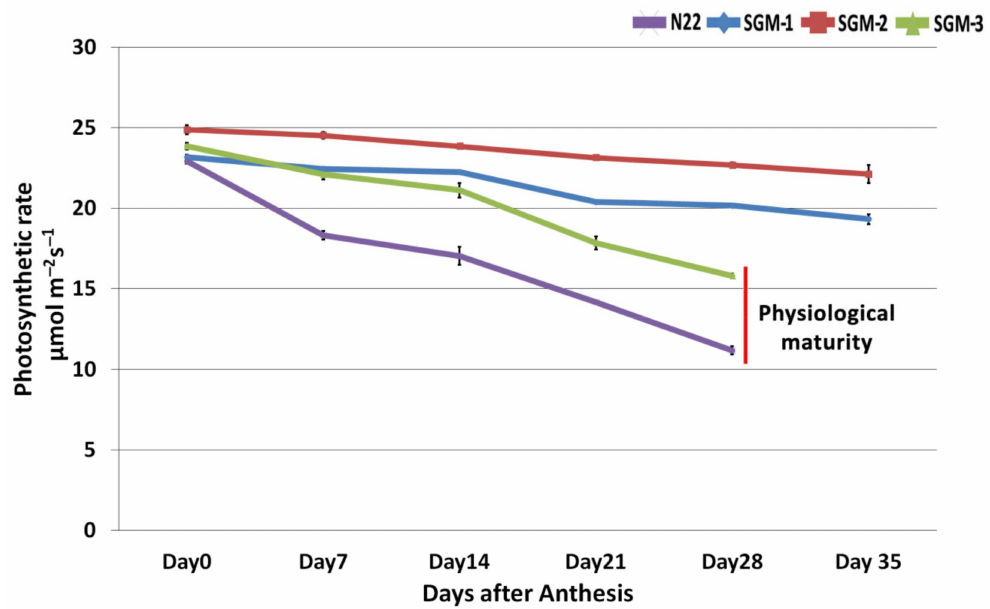
Figure 2. Photosynthetic rate of the mutants and the wild type Nagina 22 (N22) post-anthesis till physiological maturity. While N22 and SGM-3 reached physiological maturity in 28 days post-anthesis SGM-1 and SGM-2 took 35